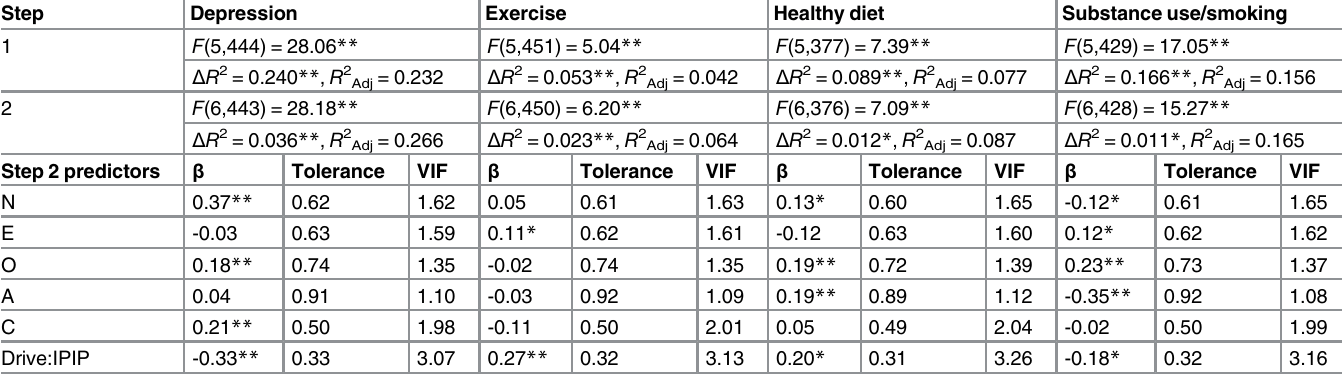
NEO PI-R = NEO Personality Inventory – Revised [60]; Drive:IPIP = Drive: International Personality Item Pool version; VIF = variance in fl ation factor, N = Neuroticism, E = Extraversion, O = Openness, A = Agreeableness, C = Conscientiousness. * p <